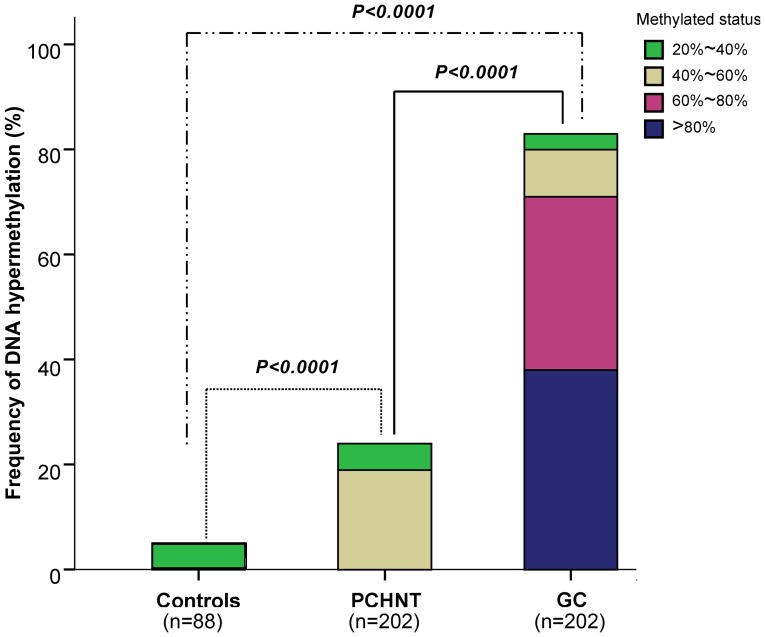
Summary of XAF1 methylation in 202 gastric cancers tissues, 202 para-cancerous histological normal tissues (PCHNTs) from the same patients and 88 non-cancer volunteers.Data shows the frequency of XAF1 hypermethylation (DNA methylation level ≥20%) in each group.